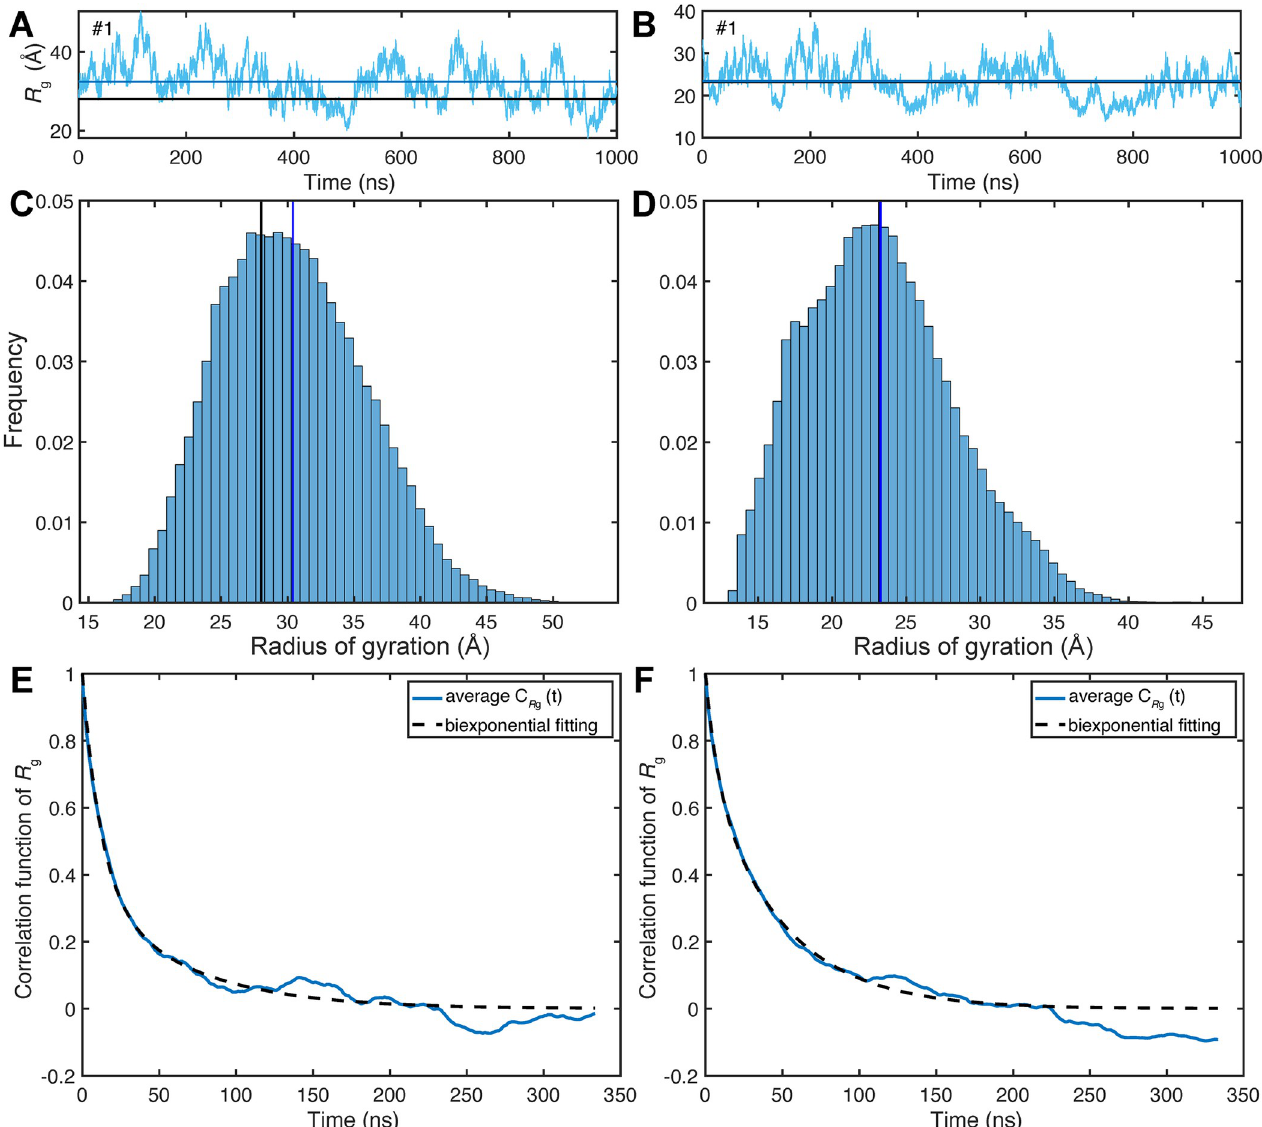
Fig 1. Radius of gyration, R g , properties of two IDPs p53TAD and Pup from microsecond MD simulations. Time-dependence of R g (t) from representative 1- μ s MD trajectories (cyan) of (A) p53TAD and (B) Pup where the horizontal blue lines correspond to the mean R g values calculated from the trajectories and the black lines correspond to the experimentally determined R g for p53TAD and the predicted R g according to polymer theory ( Eq 6 ) for Pup. R g profiles for all 10 1- μ s trajectories of each protein are shown in S1 Fig. Histograms of the R g (t) distributions over all 10 MD simulations are shown in Panels C, D (blue and black lines have the same meaning as in Panels A, B). The standard deviation of R g over all 10 MD trajectories is 5.4 Å for p53TAD and 5.0 Å for Pup. Offset- (t) of R g (t) averaged over all 10 1- μ s MD trajectories are shown for (E) p53TAD and (F) Pup. The dashed lines belong to free time-correlation functions C R g non-linear least squares fits of C R g (t) by biexponential functions whereby the best fits are obtained for p53TAD with τ a = 12 ns (63% of total amplitude), τ b = 62 ns (37%) and for Pup with τ a = 8 ns (29%), τ b = 48 ns (71%). global maximum corresponding to prolate-shaped (cigar-like) structures ( P = 1) and a second (local) maximum corresponding to disk-like structures ( P = -1). The distribution of the pro- lateness of Pup is more balanced between positive and negative values with < P > = 0.2 than for p53TAD, which has a higher tendency to adopt prolate-shaped conformers ( < P > = 0.35), whereas the Gaussian chain distribution ( < P > = 0.3) lies between the two IDP distributions.